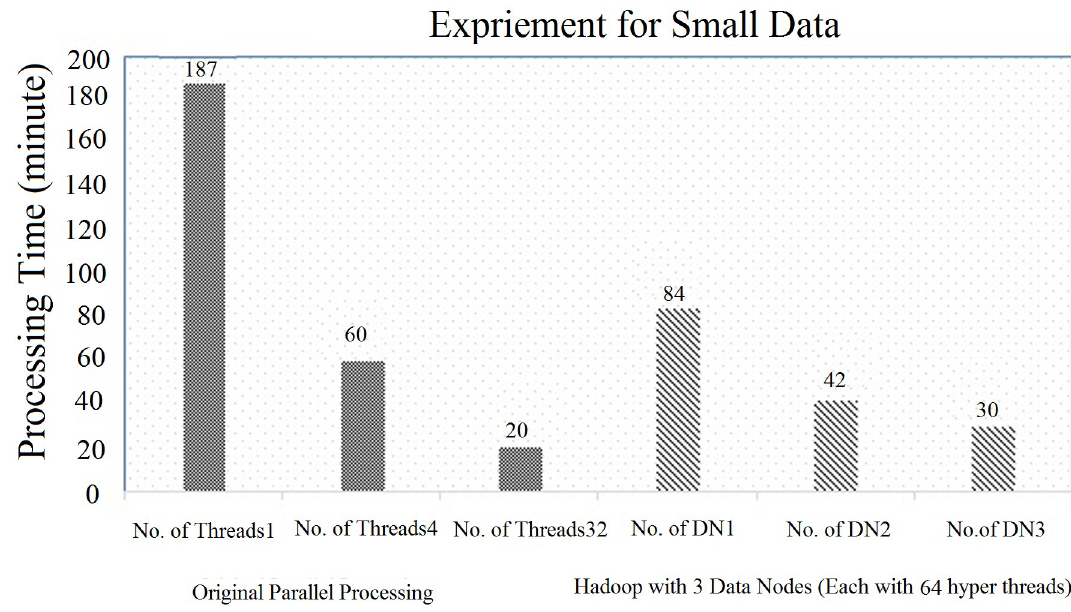
Fig 9. Comparison of original parallel processing with Hadoop (3 data node) with 64 hyper threads.